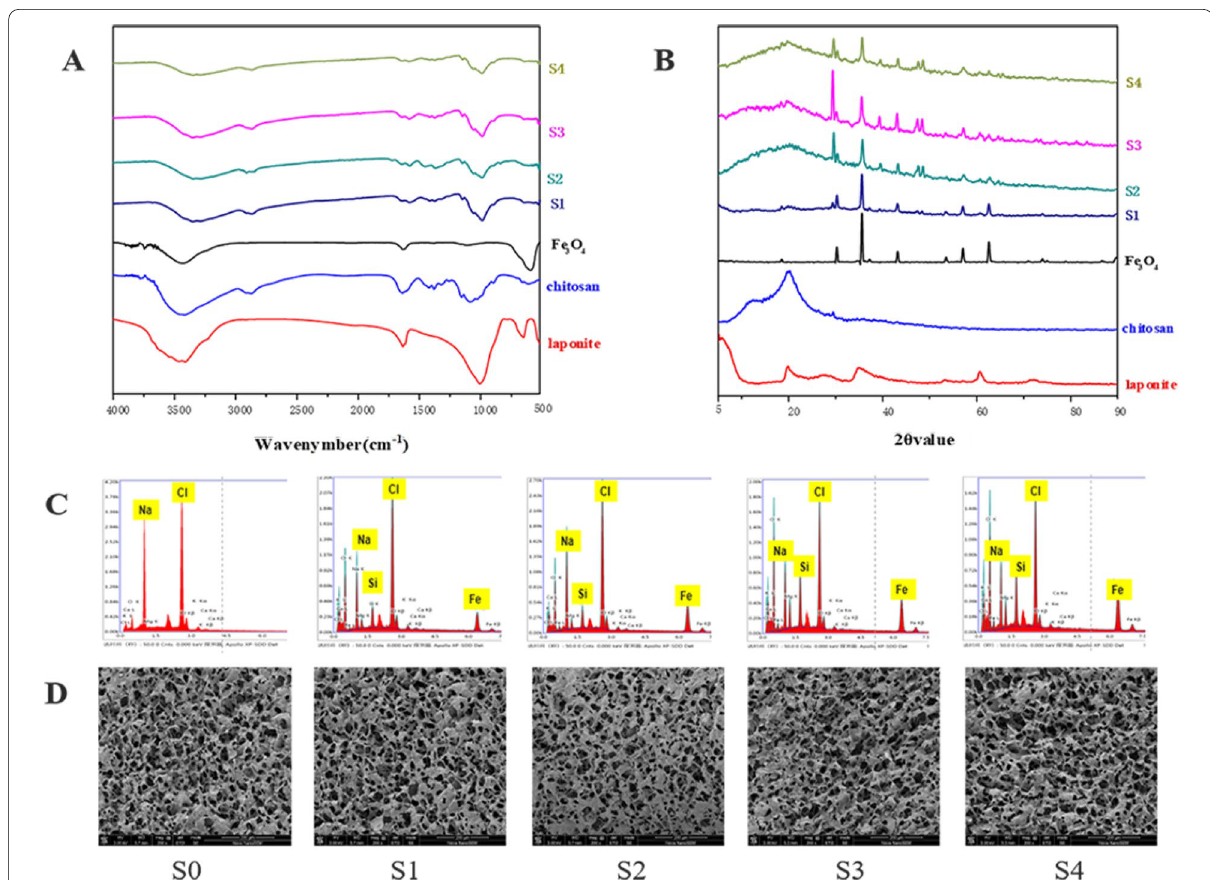
Fig. 4 Characterization of scaffolds. A FTIR spectra of chitosan, laponite, Fe 3 O 4 and scaffolds. B XRD spectra of chitosan, laponite, Fe 3 O 4 and scaffolds. C EDS of scaffolds. D SEM images of scaffolds. Scale bar: 200